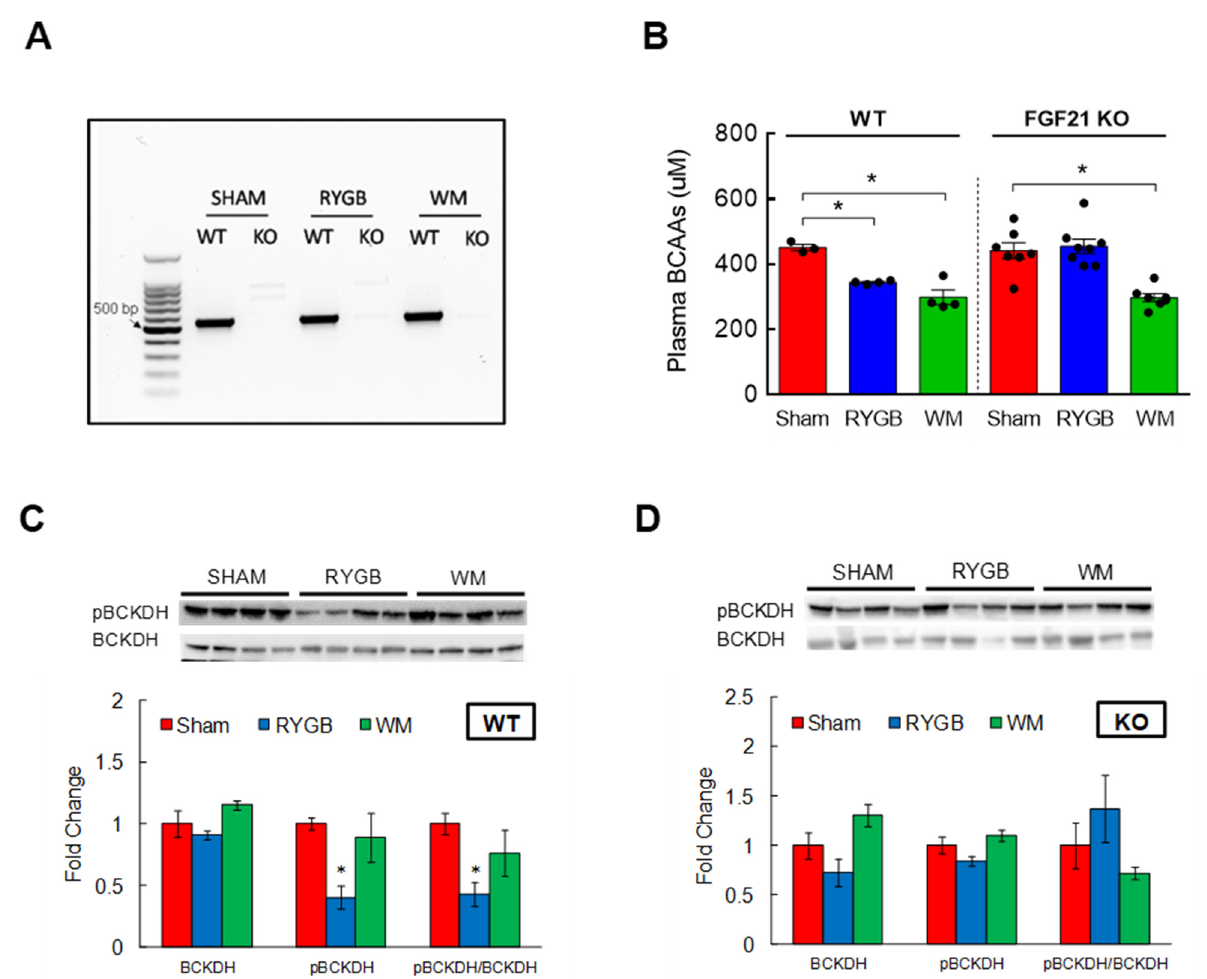
Figure 5. Enhanced BCAA metabolism following RYGB surgery is lost in FGF21 KO mice. Eight- week-old male WT ( n = 3–4/group) or FGF21 KO mice ( n = 7–8/group) were fed a two-choice diet (regular chow or 60% high-fat diet) for 10 weeks before being subjected to sham or RYGB surgery or caloric restriction. ( A ) Verification of FGF21 deletion by PCR. ( B ) Plasma BCAAs measured from tail blood after overnight fasting at 6 weeks postsurgery. ( C ) Protein expression of hepatic BCKDH, its phosphorylated state, and inactivity index in WT or ( D ) in FGF21 KO mice after sacrifice at 11 weeks postoperatively. Analyzed by a one-way ANOVA followed by Tukey’s post hoc test. * p < 0.05 compared to sham.